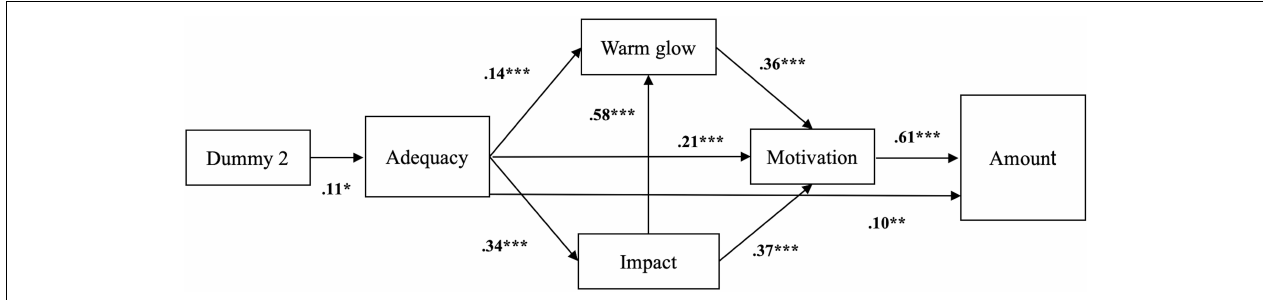
FIGURE 1 | Path model testing the indirect effect of the Dummy 2 on motivation and amount, through tangibility (i.e., adequacy), warm glow and impact. Coefficients presented are standardized. * p < 0.05, ** p < 0.01, *** p < 0.001.